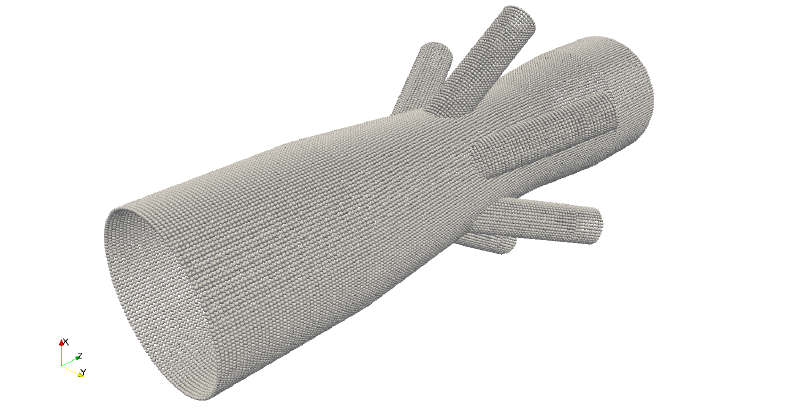
Figure 13. Boundary particles of the discretized geometry for the cylindrical nozzle case.